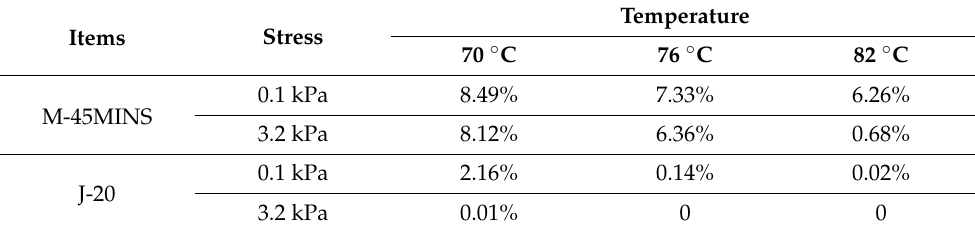
Table 4. Average absolute error value for fitted multiple stress creep recovery (MSCR) test data.